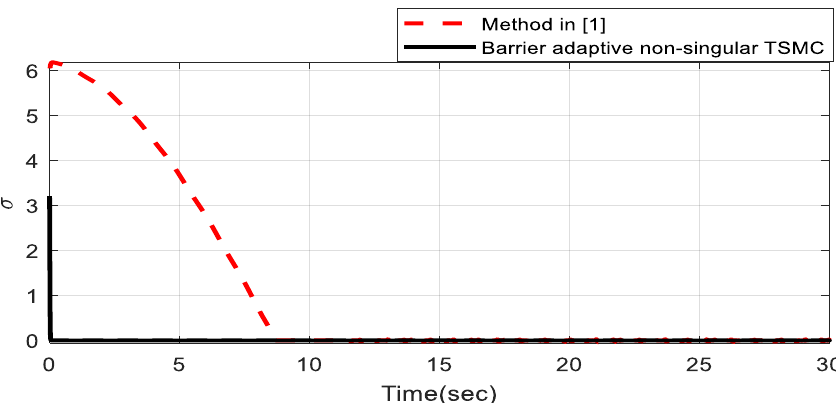
Figure 4. Time responses of the non-singular terminal sliding surface.